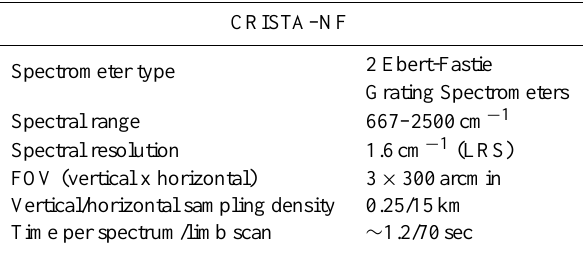
Table 5. Characteristics of CRISTA–NF. The spectral resolution is given for the low resolution spectrometer (LRS) which is capable of detecting HNO 3